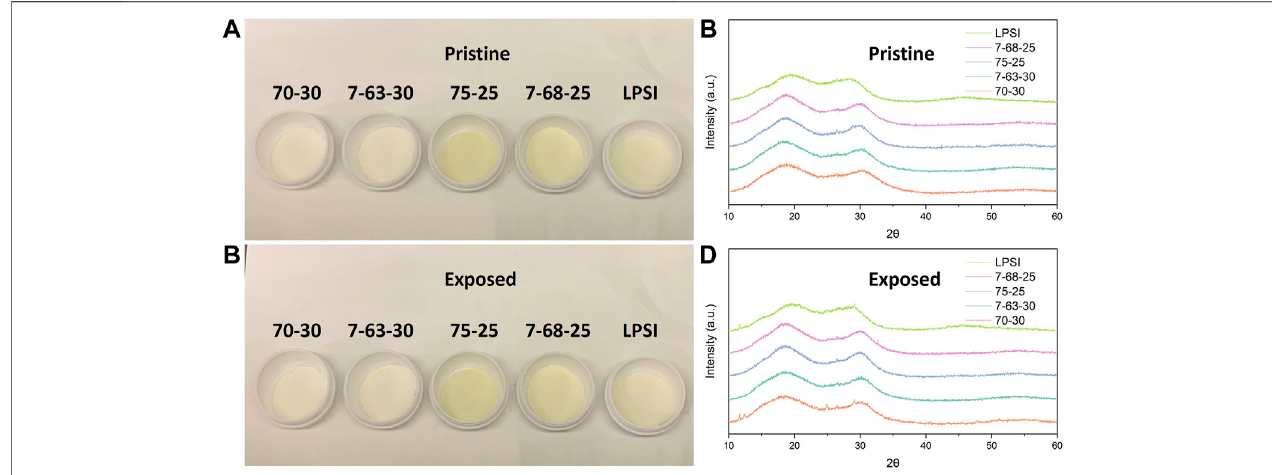
FIGURE 1 | (A) A picture of the pristine sul fi de SSE powders. (B) Powder XRD patterns of the pristine glassy SSEs. (C) A picture of the sul fi de SSE powders after exposed in dry room. (D) Powder XRD patterns of the glassy SSEs. after exposed in dry room.